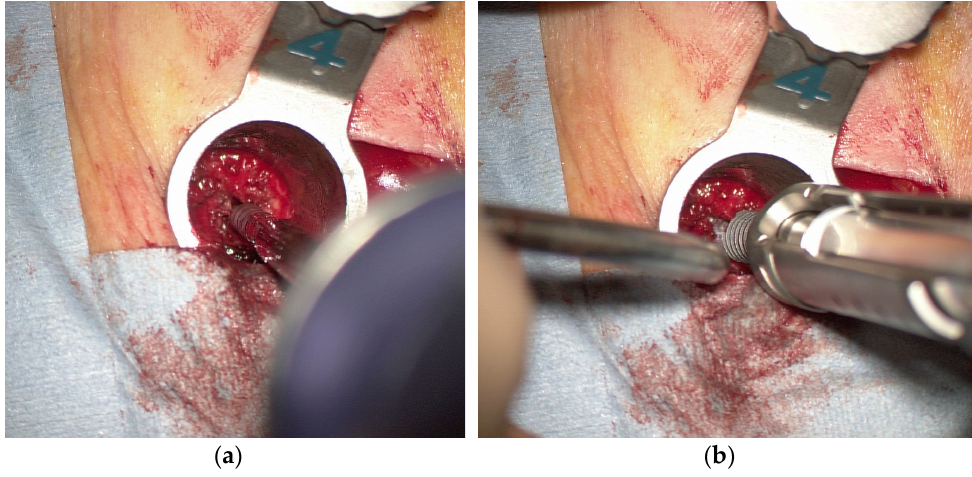
Figure 6. ( a , b ) Insertion of the pedicle screw under the